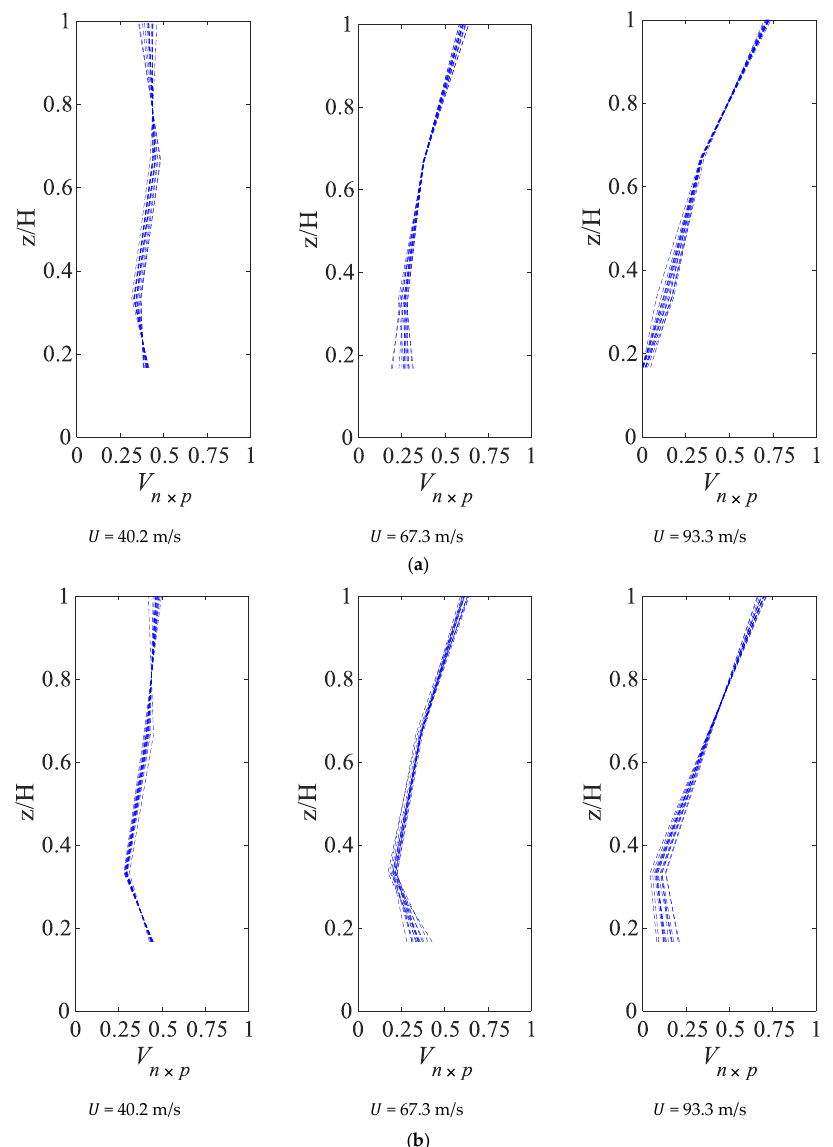
Figure 6. Eigenvector #1 along wind ( a ) and across wind ( b ) variability as a function of the wind velocity.